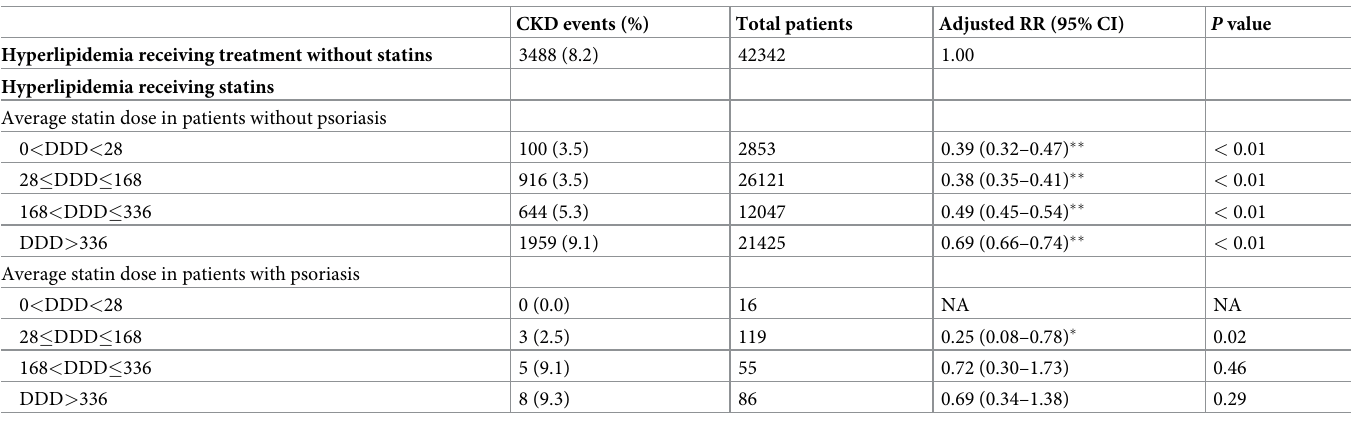
Table 4. Statin treatment for hyperlipidemia and the risk of incident CKD without dose-dependent protective effect. CKD events